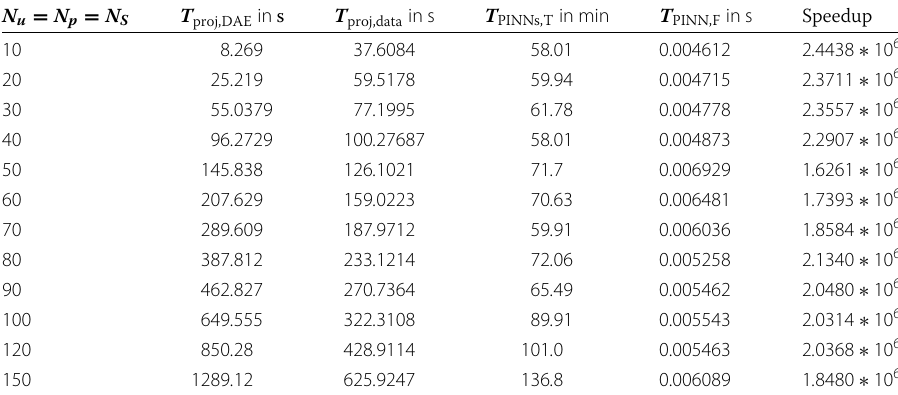
Table 3 The computational time taken by different tasks needed for the implementation of the POD-Galerkin PINN ROM (i) the second column reports the time taken for performing the projection of the equations (computing the reduced quantities in the reduced DAE system) in parallel setting using 24 processors, (ii) the third column details the CPU time (also using 24 processors in parallel) consumed for the computation of the PINNs output data represented by the L 2 projection coefficients of the different variables N u = N p = N S T T T T PINNs,T in min PINN,F in proj,DAE in s proj,data in s